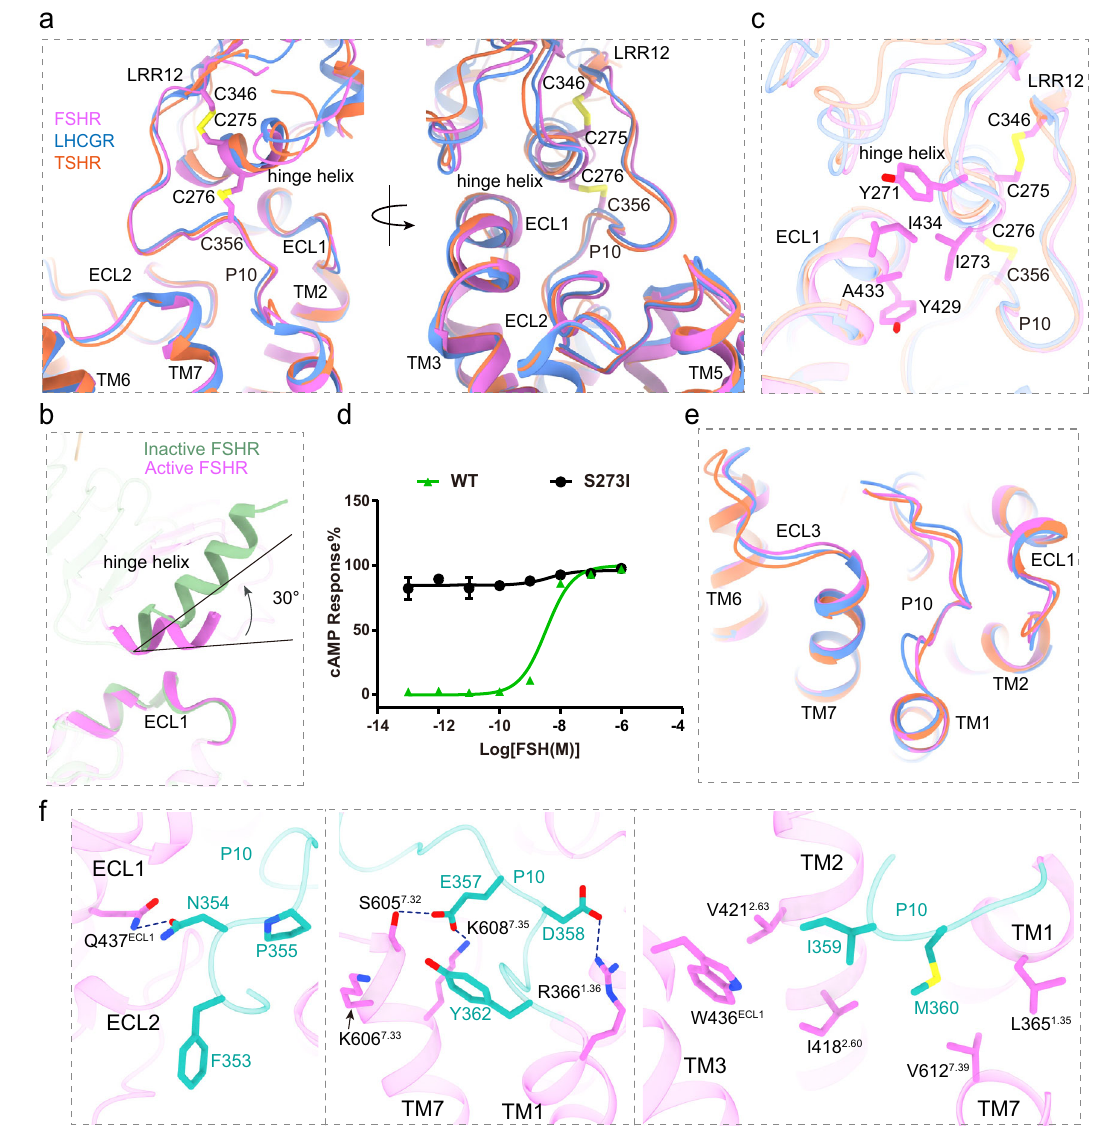
Fig. 3 | Structural basis for FSHR activation signal transduced from ECD to TMD. a Structural comparison of FSH-FSHR-Gs complex with CG-LHCGR-Gs and TSH-TSHR- complexes. The similar ECD-TMD con fi guration in three structures is shown, and the two conserved disul fi de bonds in FSHR are shown in sticks. b Structural comparison of the hinge helix in the inactive and active FSHR struc- tures.The anglewas measured atthe C α atomsof S273and R283from the inactive FSHRandC276fromtheactiveFSHR. c The fi rstconservedinterfacebetweenhinge